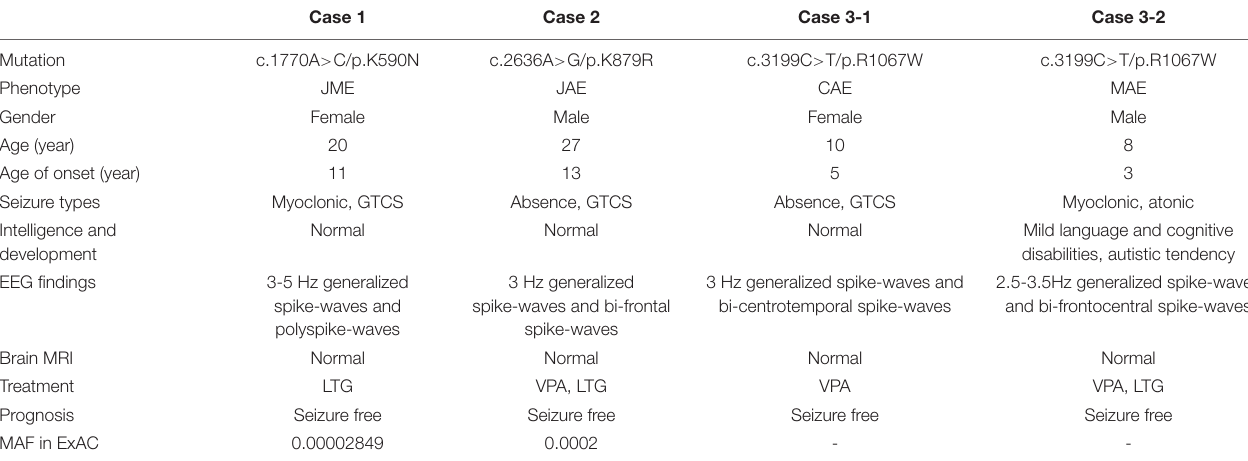
TABLE 1 | Clinical manifestations of the cases with GRIN2A mutations.